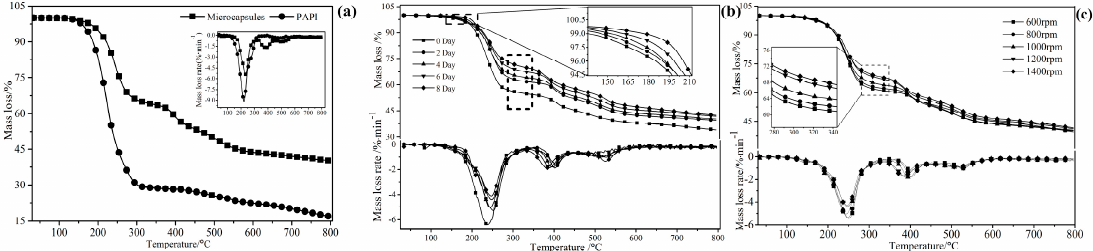
Figure 9. TGA mass loss and its derivatives curves of PAPI and synthesized microcapsules ( a ), changed in different storage time at room temperature ( b ) and by synthesized at various agitation rate ( c ).